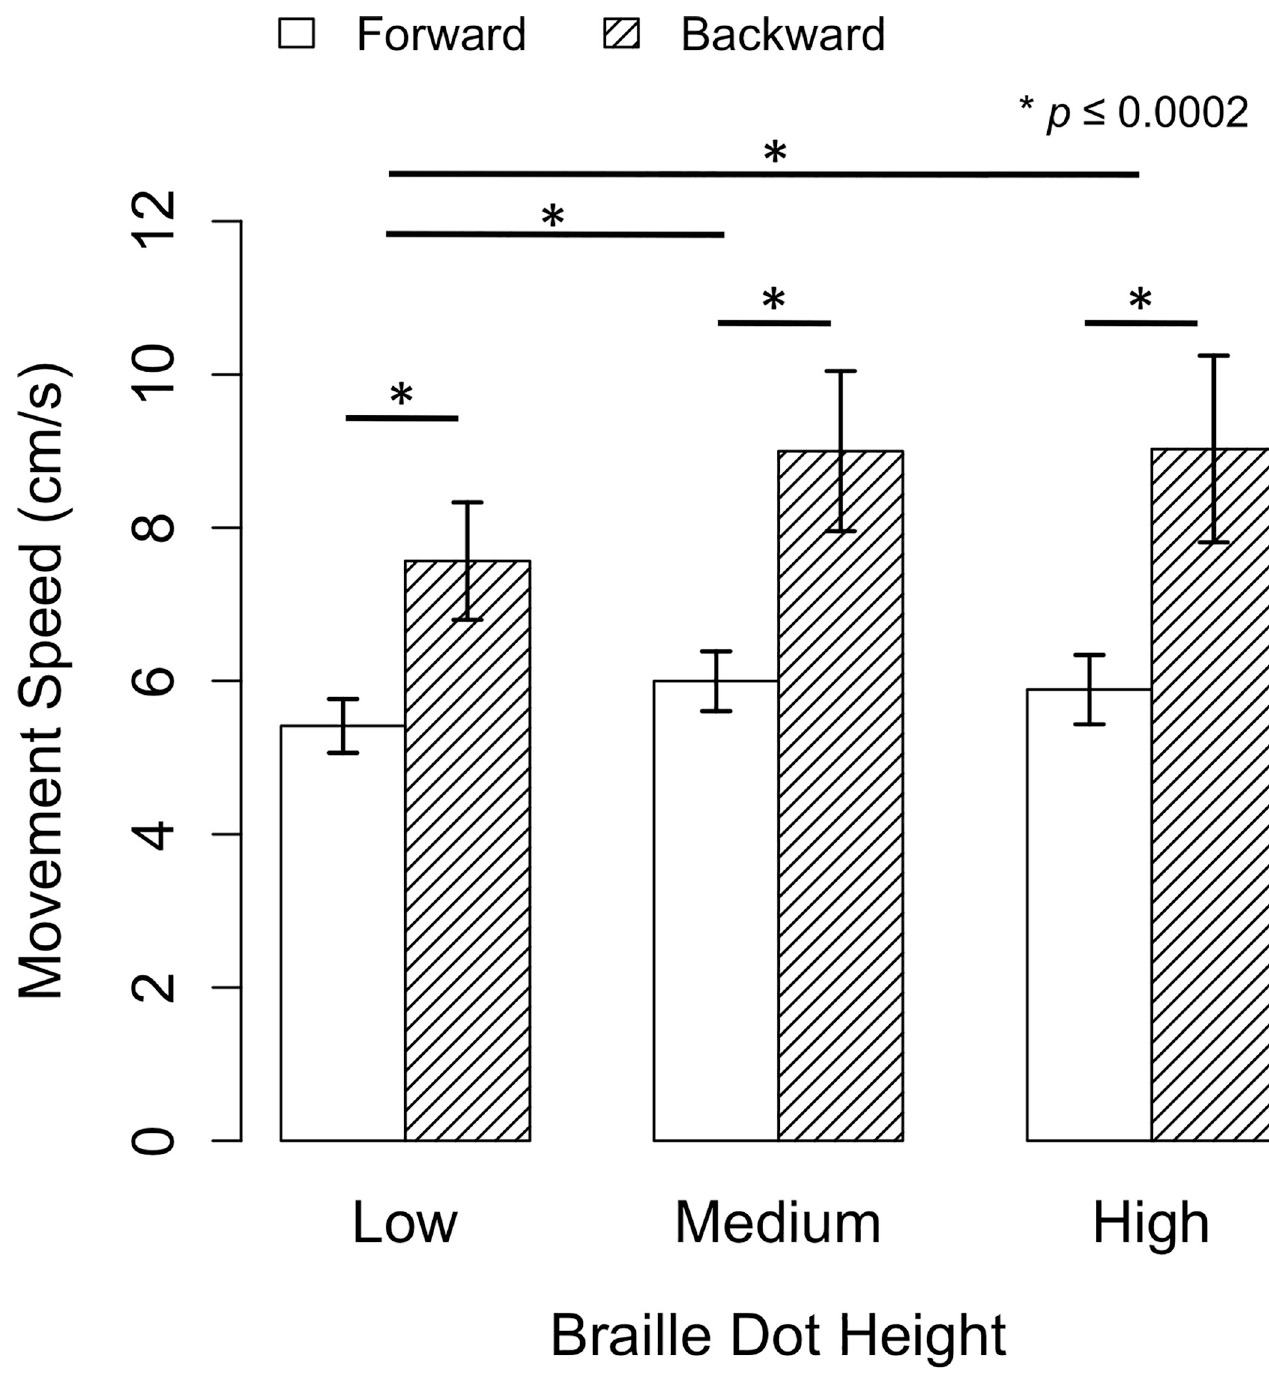
Fig 6. Average forward and backward finger movement speeds (cm/s) with SEMs at three braille dot